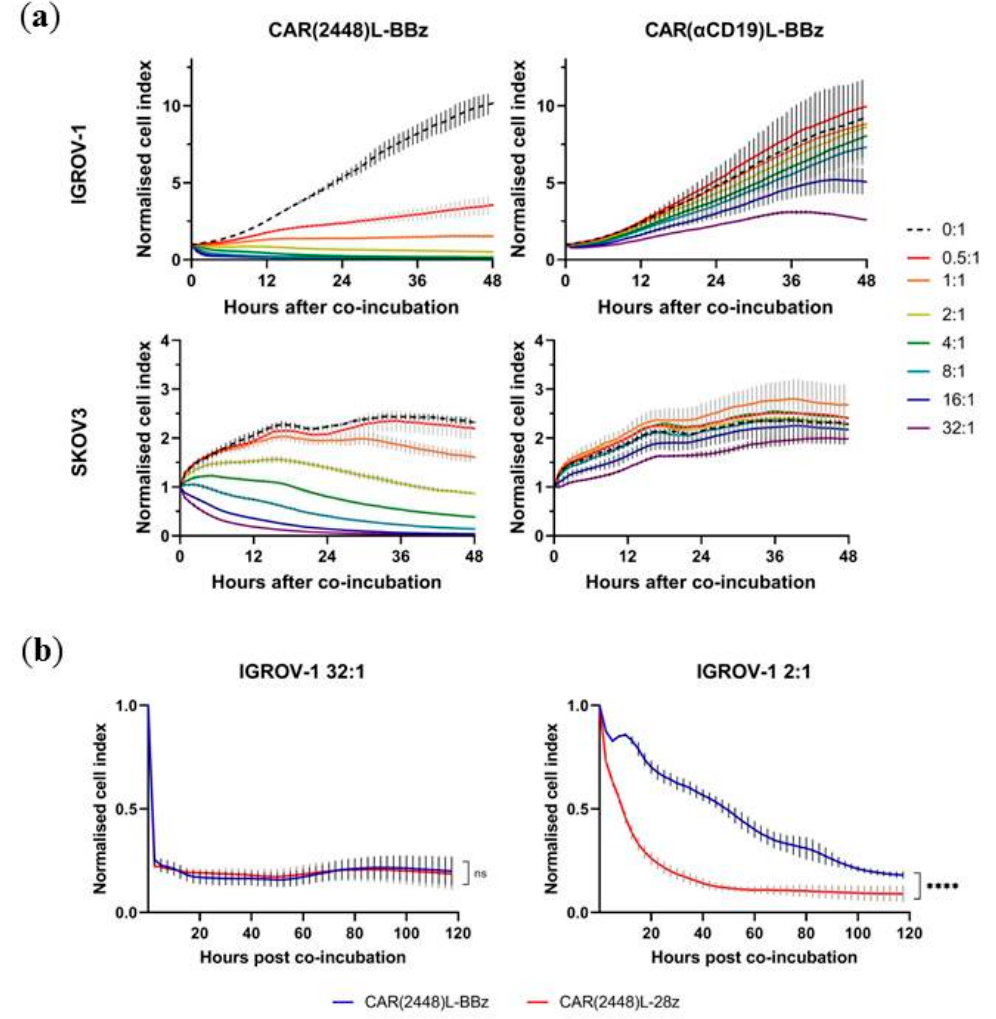
Figure 3. Lentivirally transduced CAR(2448)L T cells mediates dose-sensitive cytotoxicity upon recognition of target cells. ( a ) Real-time cytotoxicity of CAR(2448)L-BBz and control CAR( α CD19)L-BBz T cells against target cells at varying E:T ratios. Cytotoxic activity of CAR T cells only observable in CAR(2448)L T cells against ANXA2 + target cells. ( b ) Real-time cytotoxicity of CAR(2448)L T cells against IGROV-1 target cells at 32:1 and 2:1 E:T ratios. For all subfigures, abbreviations: ns not significant. **** p <